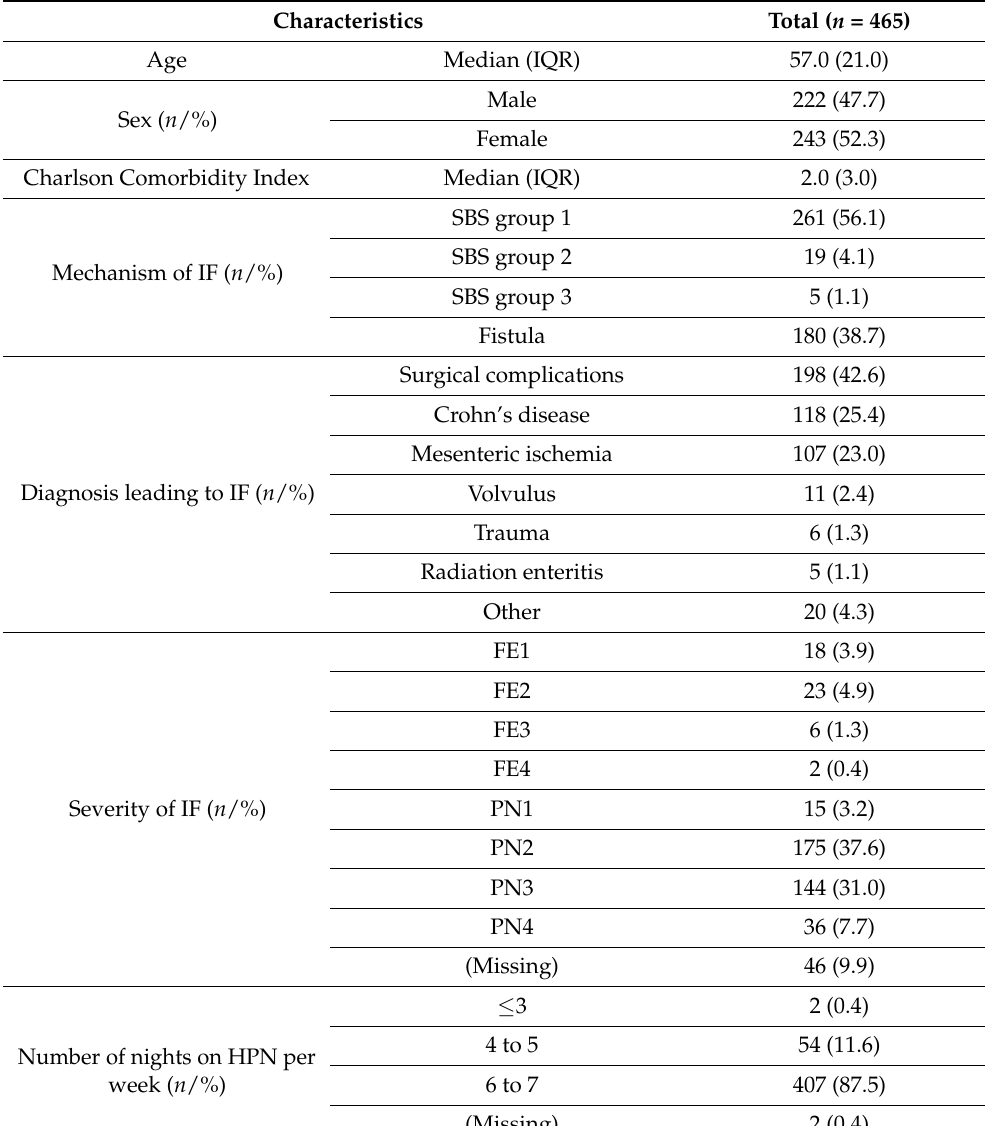
Table 1. Patient demographics and clinical characteristics at HPN initiation. Severity of IF was classified according to ESPEN guidelines